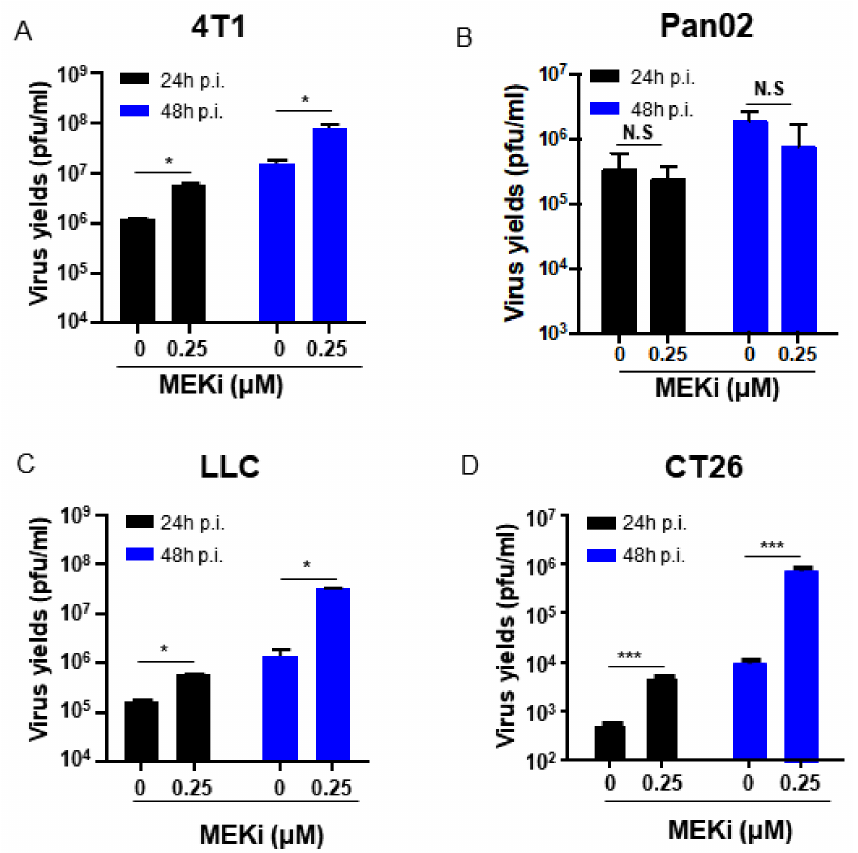
Figure 4. MEKi treatment increased oHSV virus yields in KRAS mutated cancer cells. 4T1 ( A ), Pan02 ( B ), LLC ( C ), and CT26 ( D ) cells were pretreated with 0.25 µ M of Trametinib (MEKi) for 2 h and then infected with 0.1 PFU/cell T3855. The virus-containing samples were harvested at 24 and 48 h post-infection, respectively. Additionally, then the titration was measured by conventional plaque assay on Vero cells after three freeze–thaw cycles. N.S. (not significant); p > 0.05, * p < 0.05, *** p <